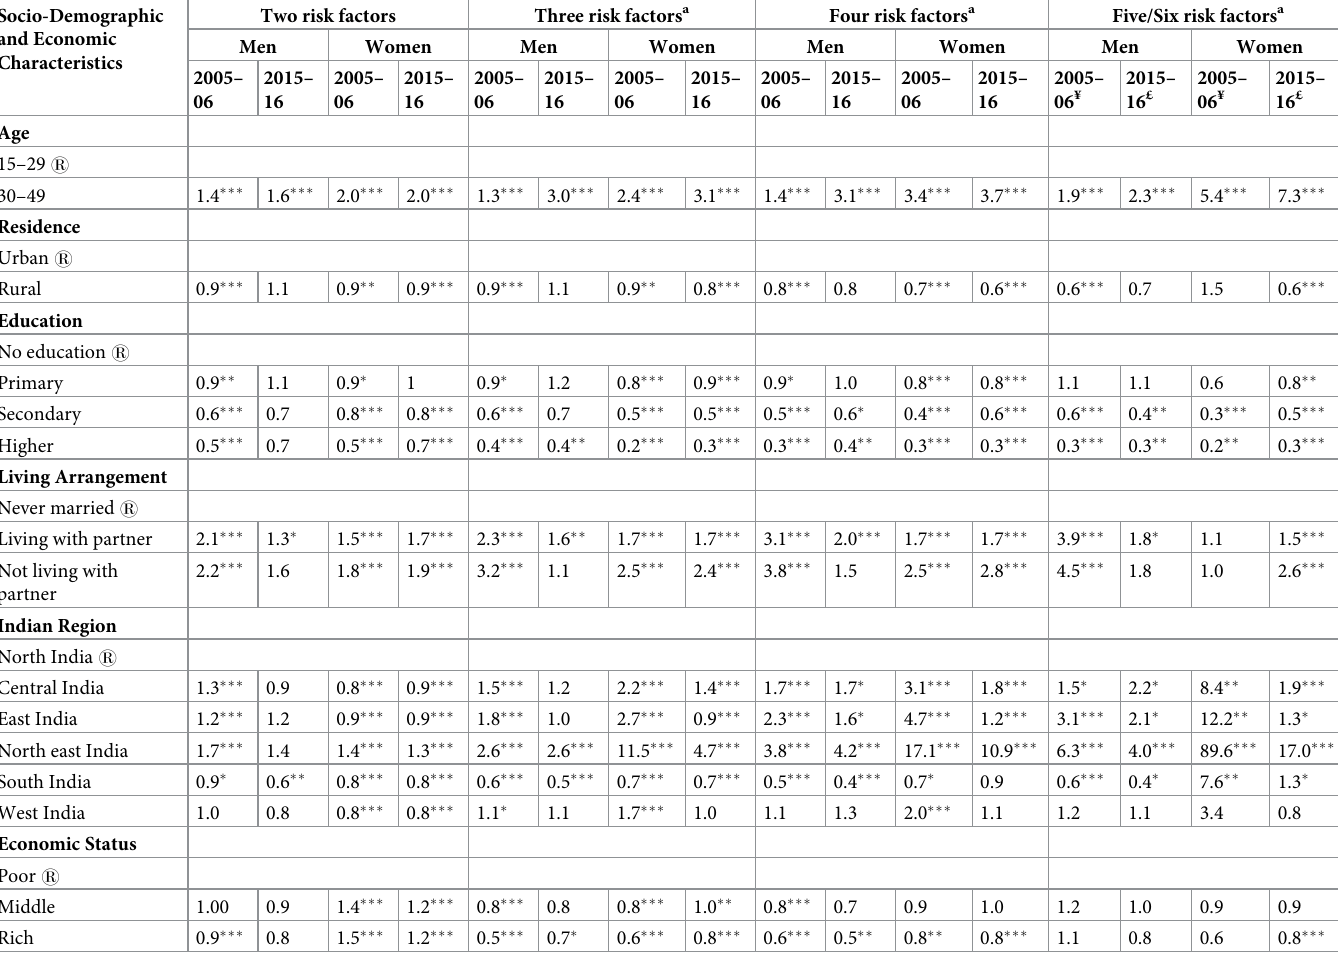
Table 4. Estimated adjusted odds ratio showing the likelihood to occurrence of multiple (one, two, three, four and five/six) risk factors among Indian men and women by their socio-economic and demographic characteristics, India, 2005–06. Socio-Demographic and